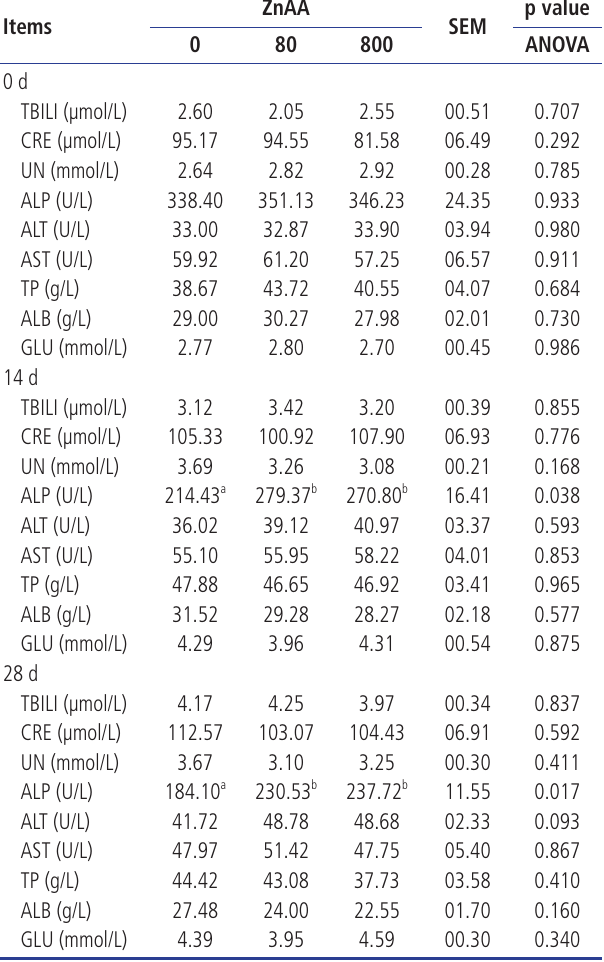
Table 7. Effects of zinc amino acid complex (ZnAA) on serum biochemical parameters in weaned pigs 1) (Zn, mg/kg)